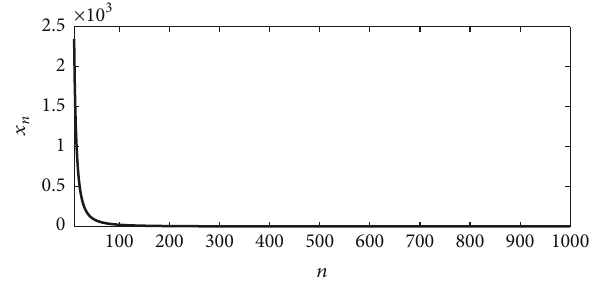
Figure 2: Problem (36): vanishing 𝑥 𝑛